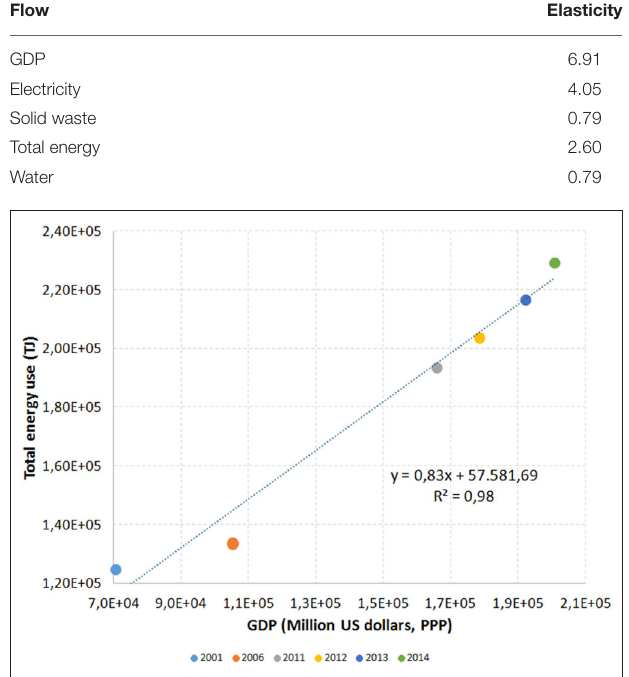
TABLE 1 | Elasticity of the metabolic flows with respect to population. Flow Elasticity